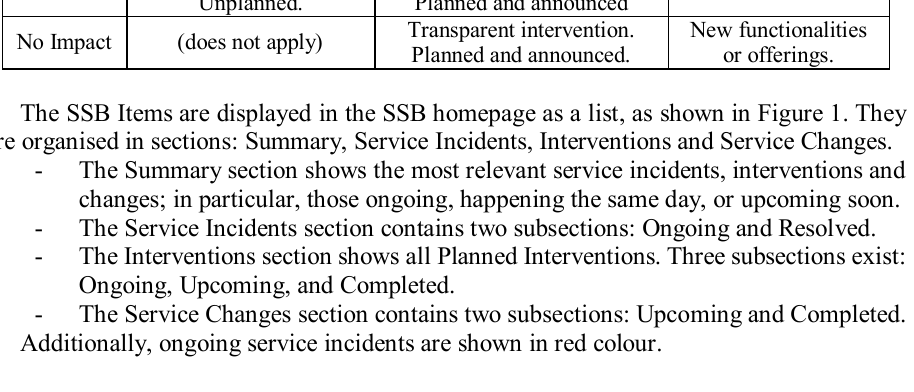
Table 1. The different kinds of SSB items, by announcement type and level of impact Service Incident Planned Intervention Service Change Service unavailable. Service unavailable. Down Unplanned. Planned and announced. Degraded performance Degraded performance or Degraded or partially unavailable. partially unavailable. Unplanned. Planned and announced Transparent intervention. No Impact Planned and announced.